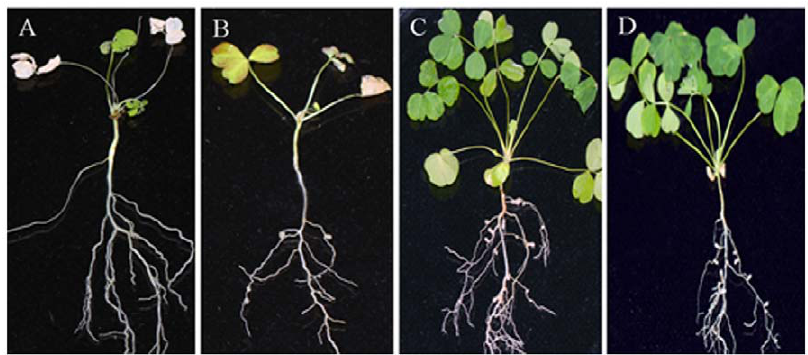
Figure 2. Plant growth test of the symbiotic ability of the disruptant HK116 on A.sinicus . (A) Control plant not inoculated Rhizobium . (B) Plant inoculated by HK116 formed pseudonodules and yellow leaves. (C) Control plant inoculated by the wild type 7653R. (D) Plant inoculated by complemented strain HK116C restored nitrogen-fixing ability.